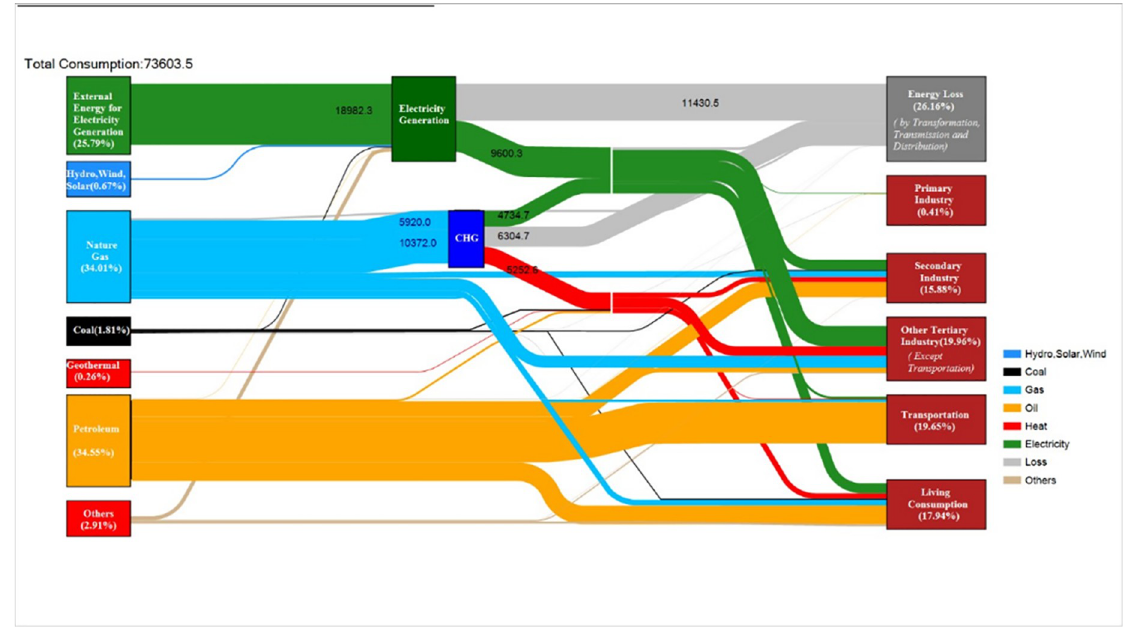
Fig 1. Energy flow diagram of Beijing in 2019 (obtained by the electrothermal equivalent